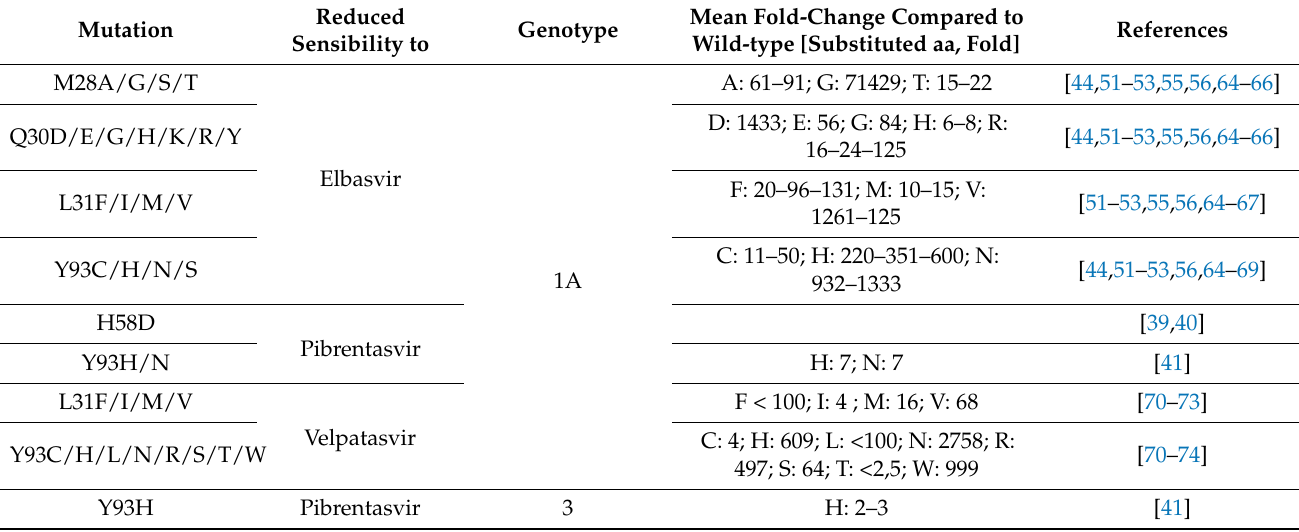
Table 4. RASs in NS5A region with fold-change compared to wild-type replicon according to HCV genotype.